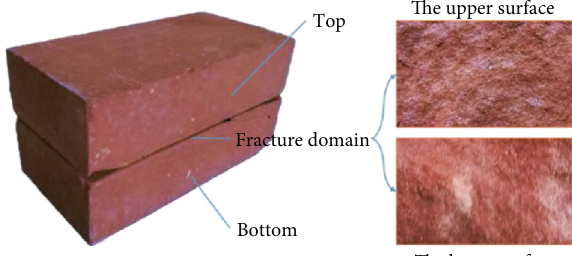
Figure 2: Images of rock fracture surfaces.